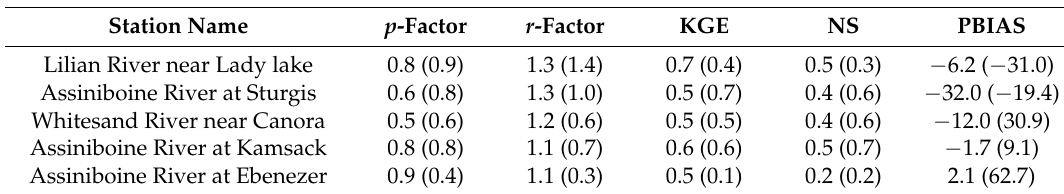
Table 3. Statistical measure of baseline model performance: Calibration (1981–2010) and validation